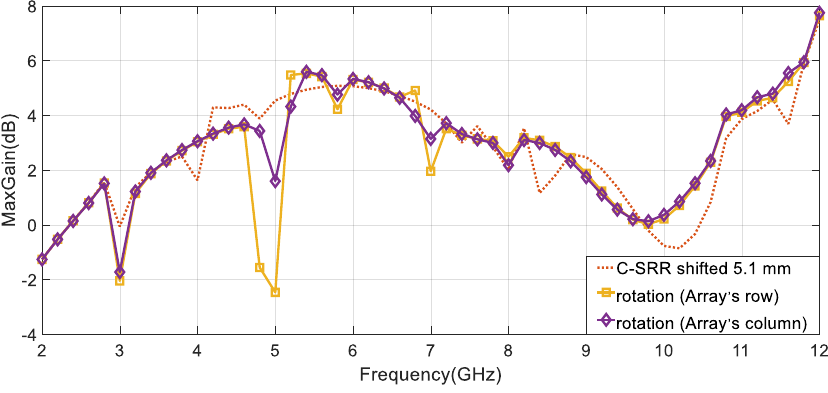
Figure 30. Maximum gain of the three antennas.